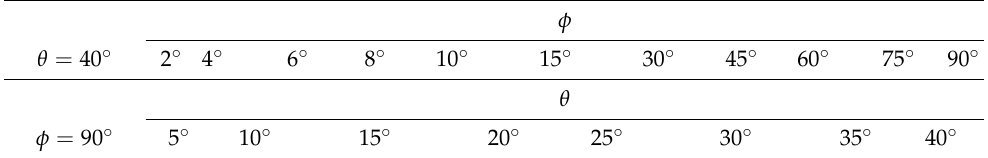
Figure 10. Configurations of TCP calibration. Table 1. The details of configuration of